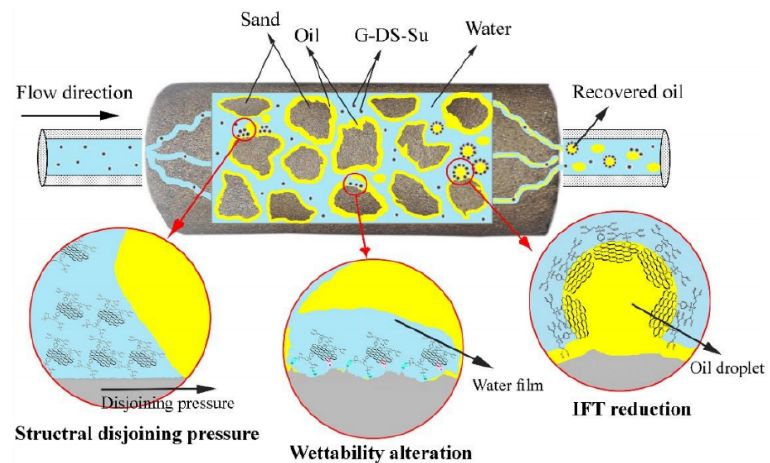
Figure 6. Schematic illustration for displacement mechanism of functionalized NPG. (Reproduced with permission from [91]. Elsevier, 2018).